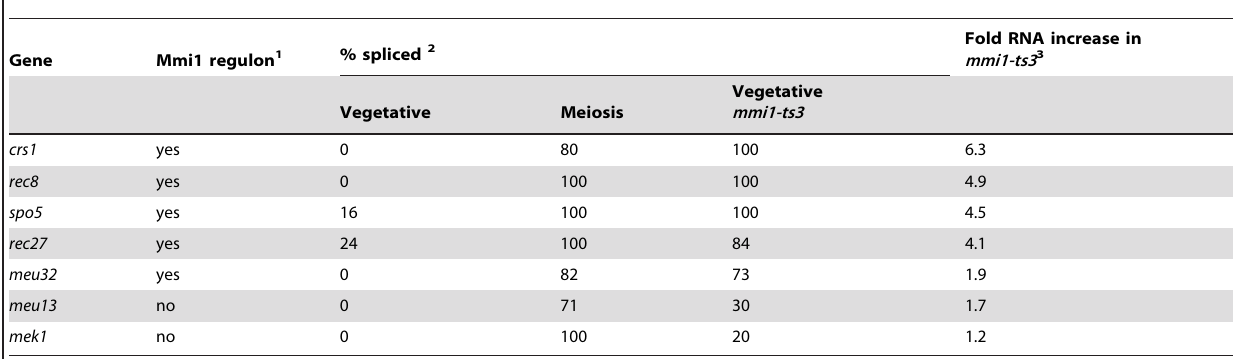
Table 1. The effects of Mmi1 on 7 meiotic